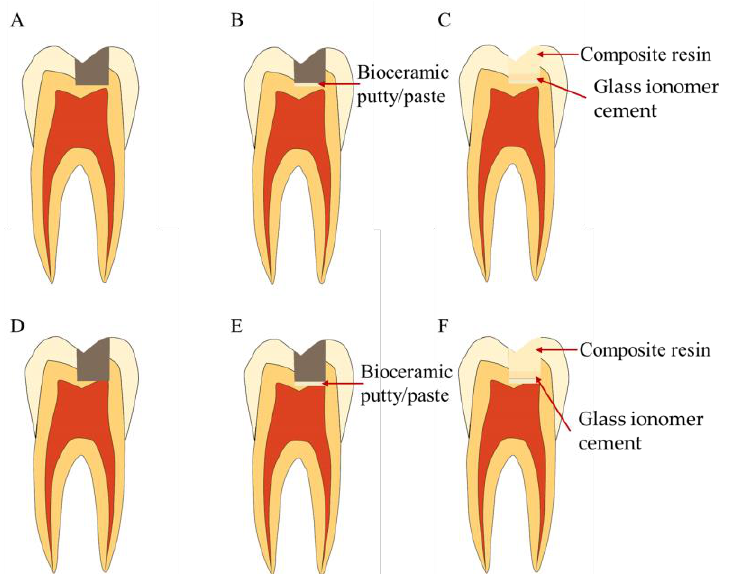
Figure 7. Treatment procedures for pulp capping. ( A – C ) Treatment procedures for indirect pulp capping. ( A ) Caries or defect close to the pulp. ( B ) Indirect pulp capping with bioceramic putty or paste. ( C ) Coronal filling. ( D – F ) Treatment procedures for direct pulp capping. ( D ) Caries or defect